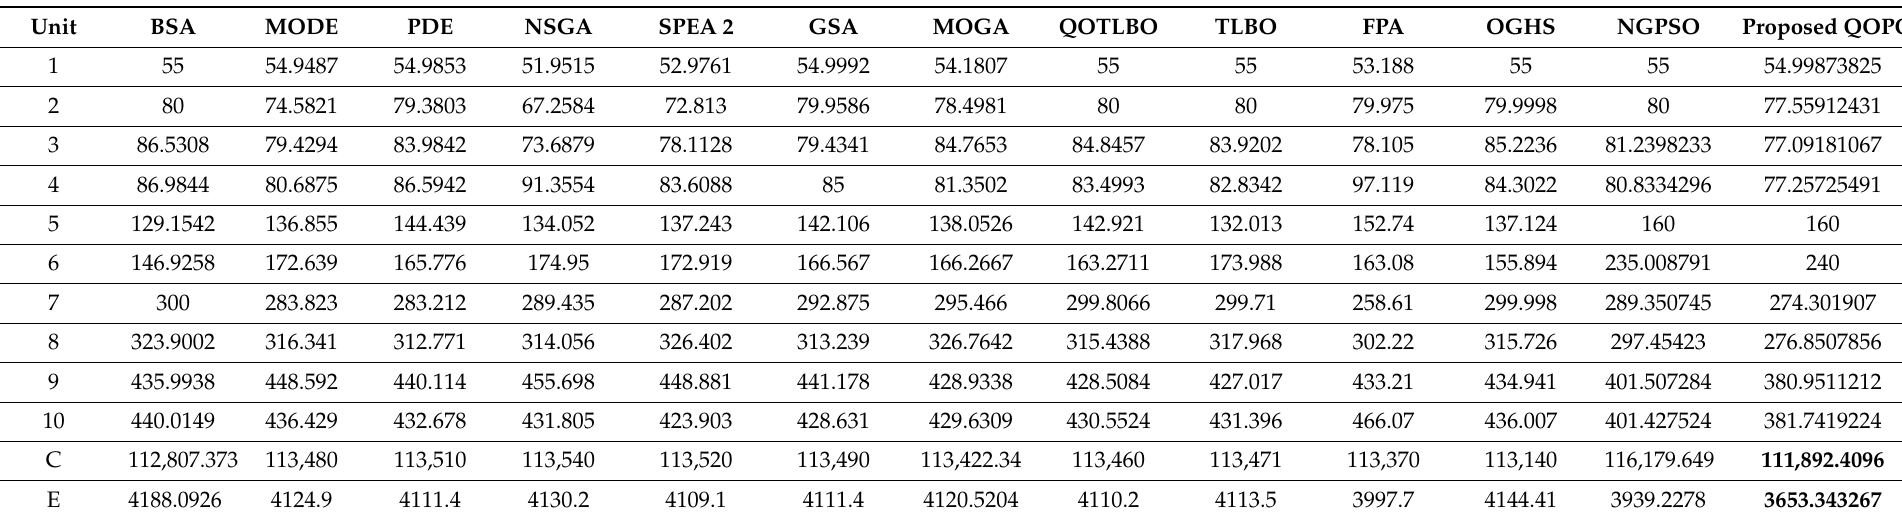
Table 11. Comparison of results of 10-unit system for the load demand of 2000